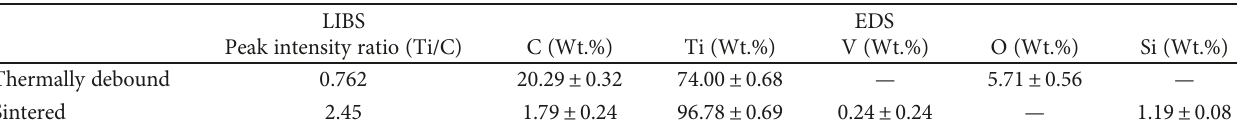
Figure 5: Enlarged section of Figure 4 showing some of the di ff erences between the Ti I and Ti II emissions from the TD (a) and S (b) samples. Table 1: Comparison of the Ti and C